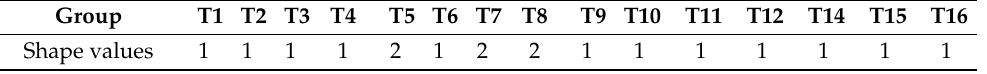
Table 4. The K average value represents the average value of the morphology value at each level of each factor, reflecting the influence of different levels of the same factor on the test results. R is equal to the maximum value of the K average value minus the mini ‐ mum value, reflecting the magnitude of change in the test index when the factor level is changed. As shown in Table 4, the range in frequency (0.75) was greater than the range in the scanning speed (0.25) and processing times (0.25). Table 3. Shape values (the evaluation of the shape value was divided into two parts: the groove textures were straight and the edge of the groove textures was clear; the value 1 was assigned if one criteria was met, and the value 2 was assigned if both criteria were met).